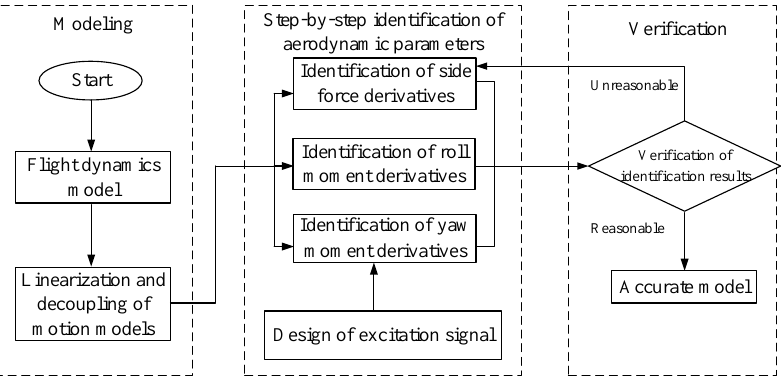
Figure 11. Steps for lateral-directional aerodynamic parameter identification.